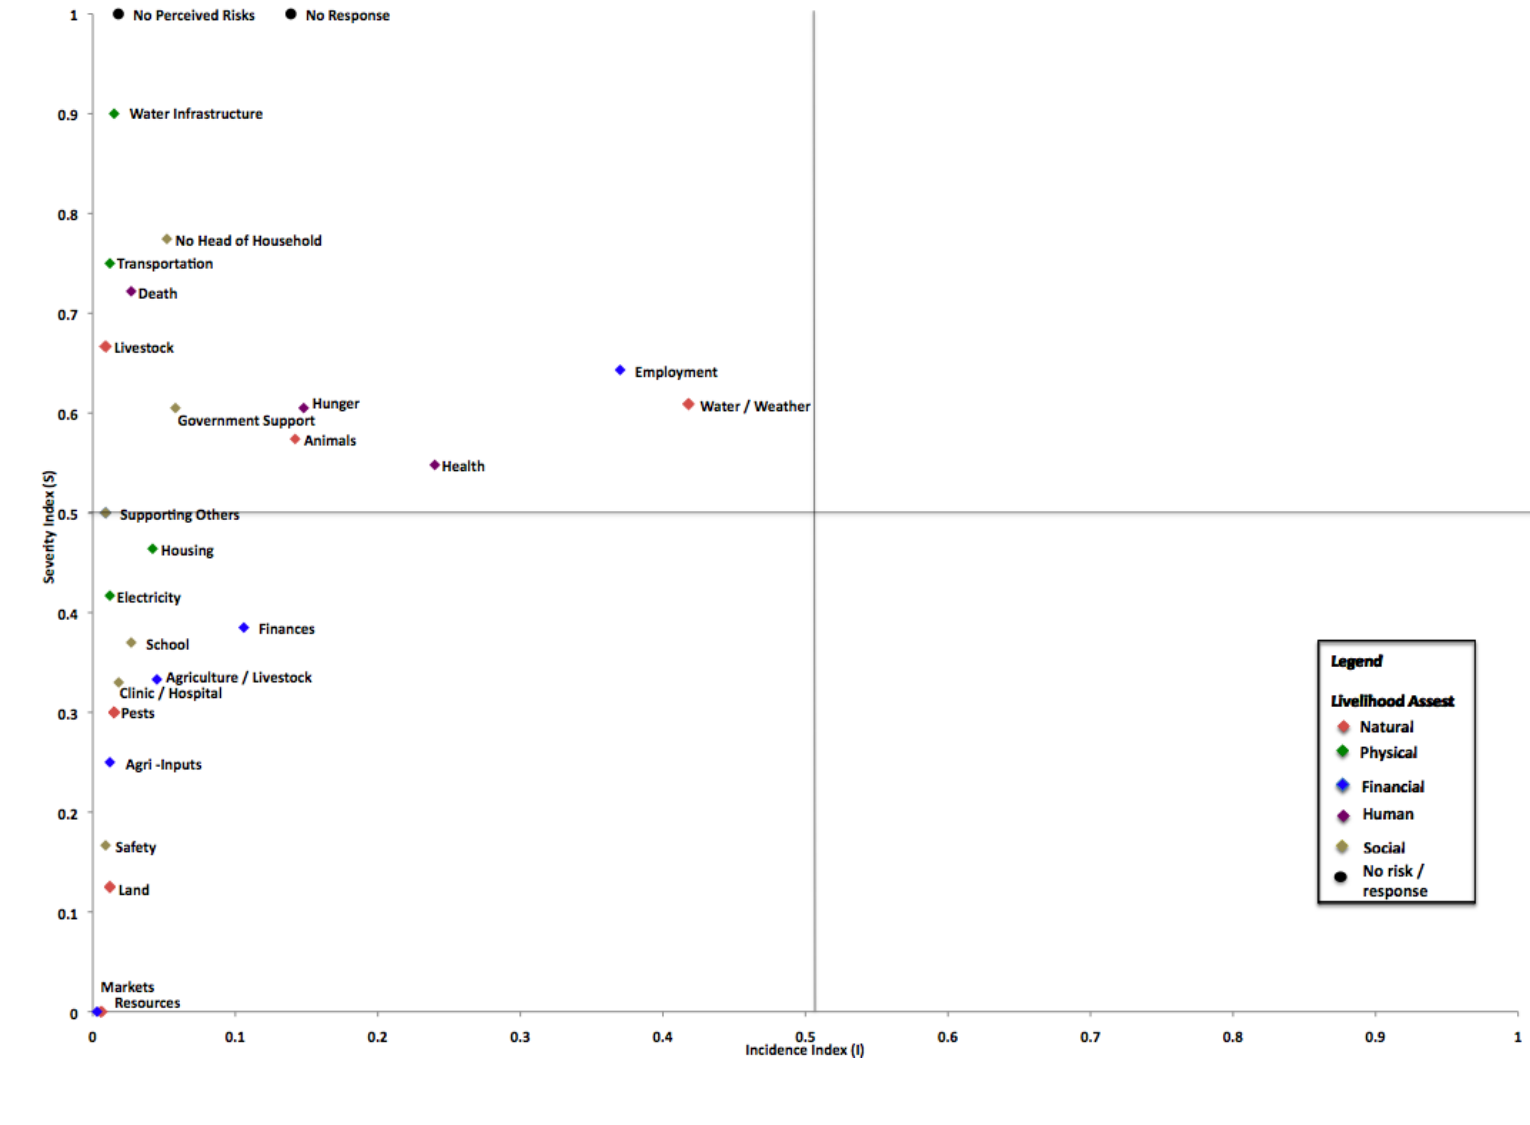
Figure 2. Risk map plotting severity index versus the incidence index for all villages surveyed. Both indices, I and R, range from 0 (lowest incidence or least severe) to 1 (highest incidence or most